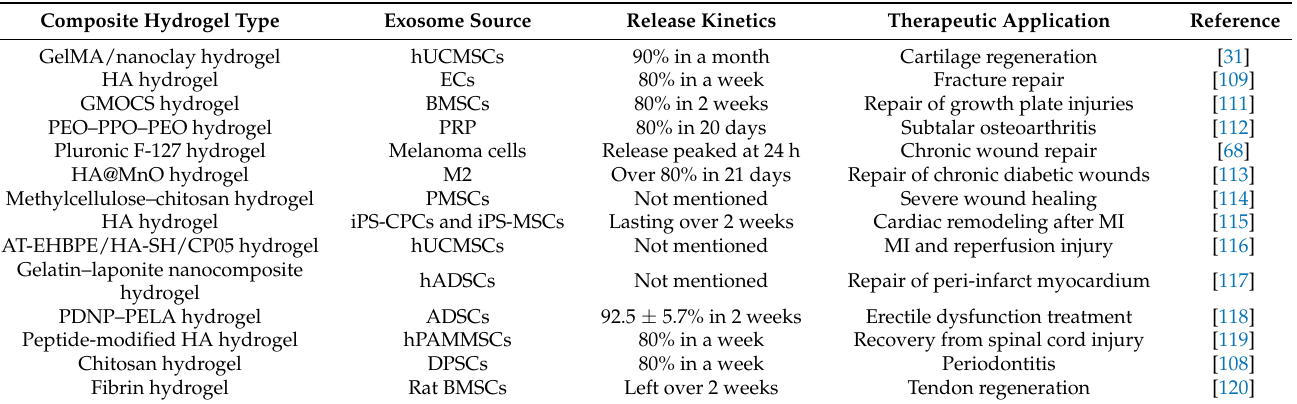
Table 1. Advances in tissue regeneration via the hydrogel encapsulation of